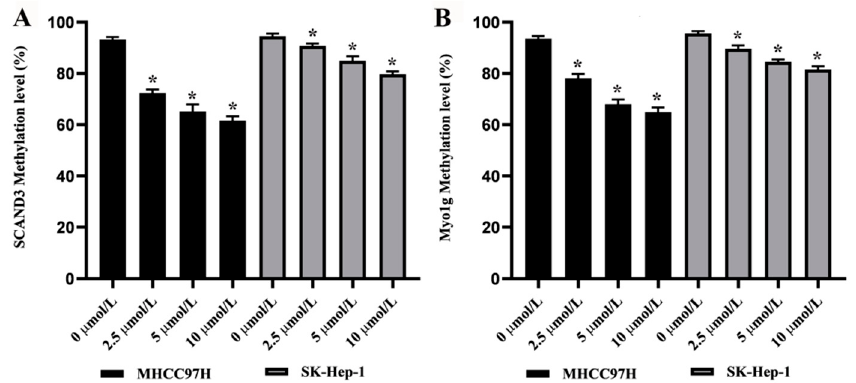
Figure 2. The methylation levels of SCAND3 and Myo1g in HCC cell lines treated with demethylating agent 5-Aza-2 ′ -deoxycytidine (5-AZC). ( A ) After 0.0, 2.5, 5.0, or 10.0 µM of 5-AZC treatment, the average methylation levels of SCAND3 were 93.30%, 72.40%, 65.17%, and 61.57% in the MHCC97H cell line, and 94.57%, 90.76%, 84.93%, and 79.67% in the SK-Hep-1 cell line, respectively. ( B ) After 0.0, 2.5, 5.0, or 10.0 µM of 5-AZC treatment, the average methylation levels of Myo1g were 93.6%, 78.17%, 67.96%, and 64.90% in the MHCC97H cell line, and 95.70%, 89.67%, 84.50%, and 81.56% in the SK-Hep-1 cell line, respectively. Statistical comparisons were computed using the unpaired t -test, * p < 0.05.